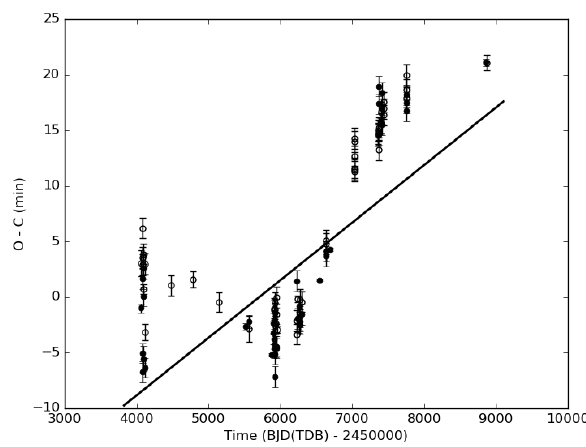
Figure 2. The O-C diagram of V1848 Ori with a linear trend on the data with χ 2 r = 89.64 and BIC = 8615.